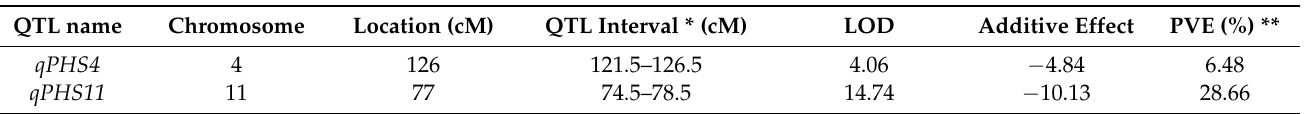
Table 2. Identification of QTLs affecting PHS